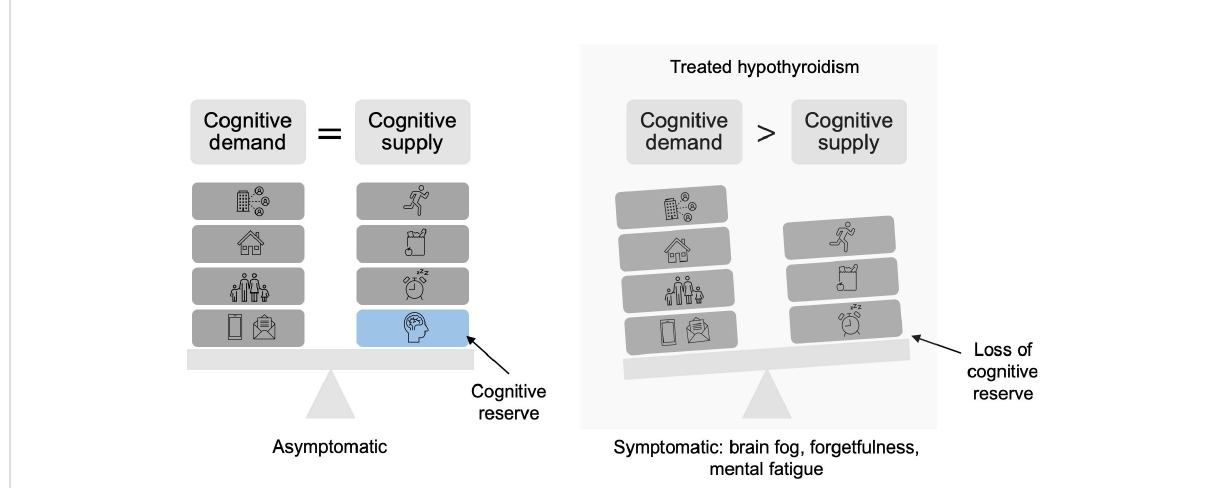
FIGURE 1 Depiction of loss of cognitive reserve in treated hypothyroidism. Cognitive demands consist of the daily responsibilities that require attention. Cognitive supply is supported by positive habits, including adequate nutrition, exercise, and rest. When full neurocognitive function due to overt hypothyroidism is not fully restored, which can occur with thyroid hormone replacement, cognitive reserve is limited. As a result, cognitive demand outweighs cognitive supply, causing